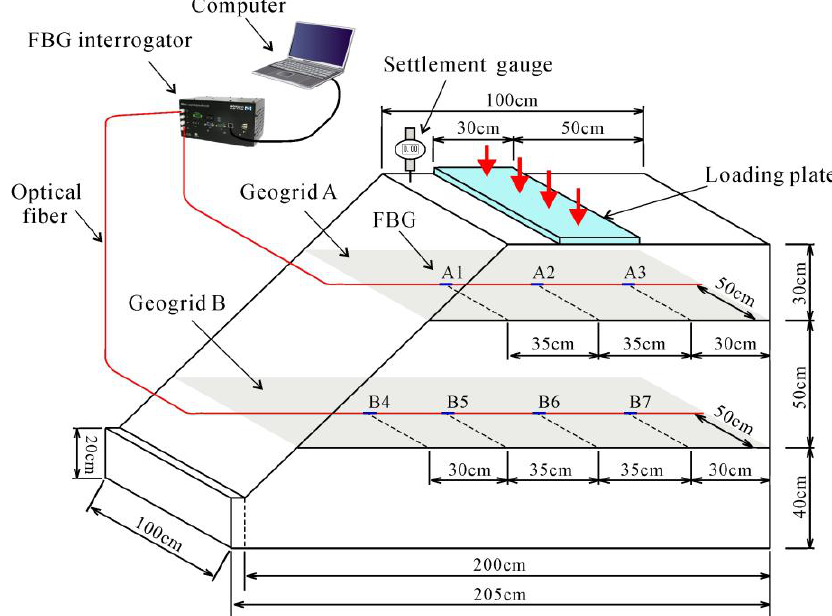
Figure 1. General arrangement of the geogrid-reinforced slope and locations of fiber Bragg grating (FBG) sensors.